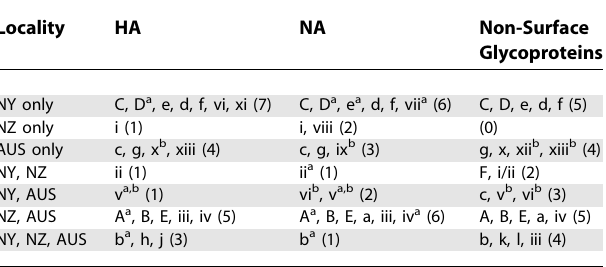
Table 1. Clades in the HA, NA, and Concatenated Six Non- Surface Glycoprotein Segment Phylogenies Comprised of Viruses from New York State, New Zealand, Australia, and Globally Locality NA Non-Surface